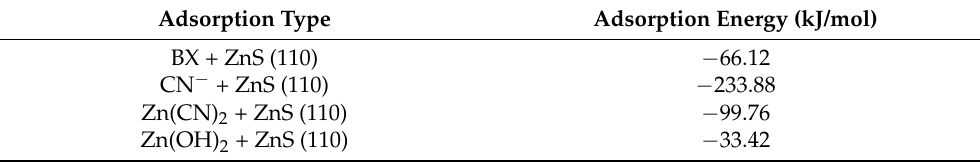
Table 1. Adsorption energy of BX, CN − , Zn(CN) 2 , and Zn(OH) 2 on the surface of sphalerite (110).